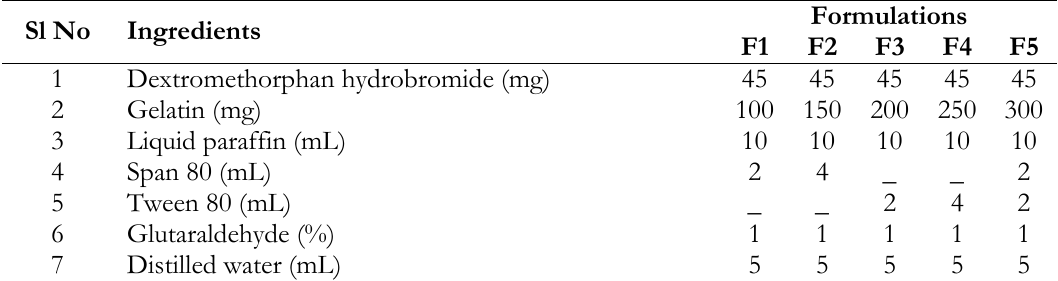
Table I. Formulation chart of DBM hollow microspheres Sl No